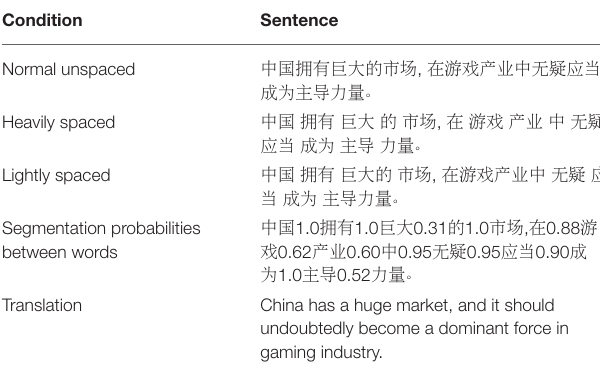
TABLE 1 | Example sentence with two spacing conditions and segmentation probabilities between words.